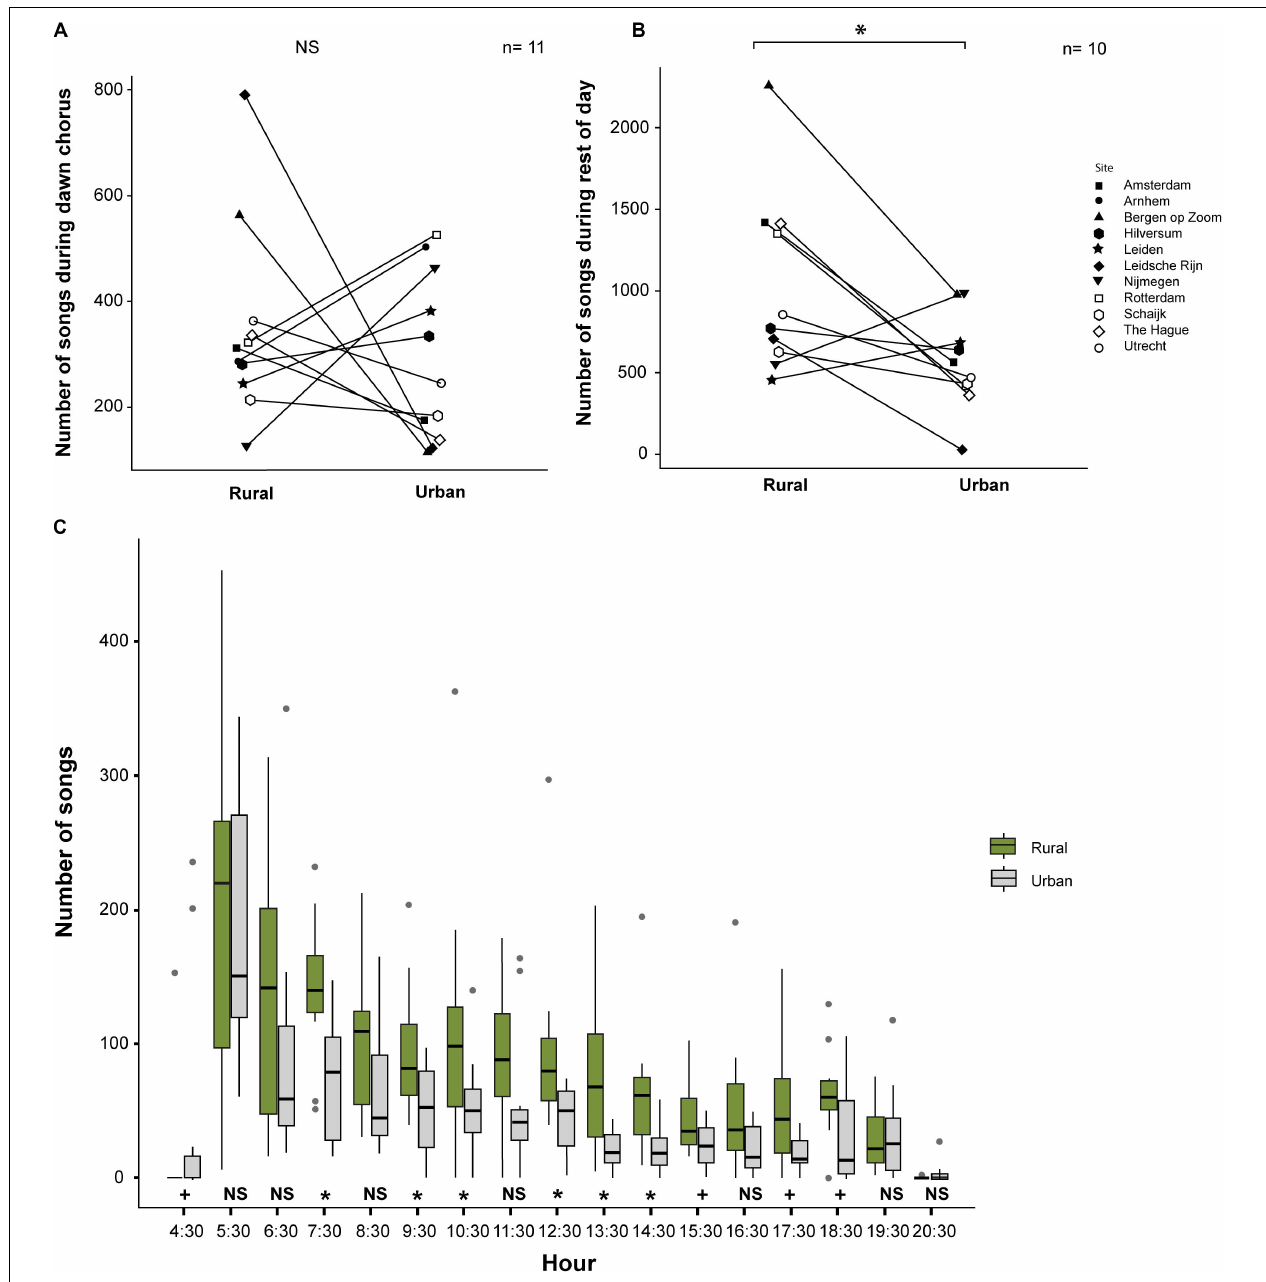
FIGURE 4 | Amount of singing for urban and rural great tits: (A) Number of songs during the dawn chorus (NS means not significant); (B) Number of songs during the rest of the day (* means a significant difference at p < 0.05 level); and (C) Number of songs per hour for both urban and rural sites (Diurnal pattern, * means a significant difference between the habitats at p < 0.05 level and + means a non-significant trend). See text for statistics.